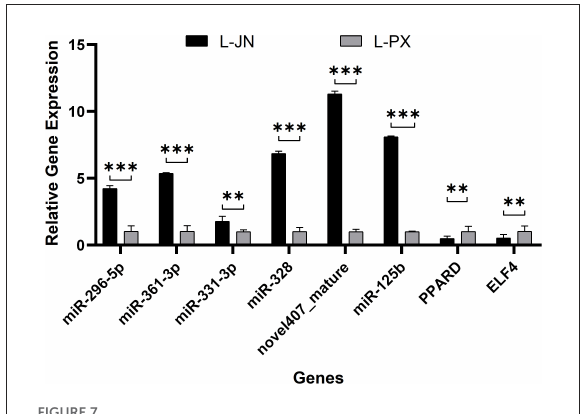
FIGURE7 qRT-PCR verification of differentially expressed genes. The differential expression of genes between intramuscular and subcutaneous adipose tissue in Laiwu pig was verified qRT-PCR. * p < 0.05; ** p < 0.01; *** p <